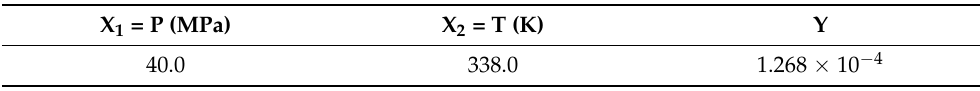
Table 5. Final attributes amount for the supreme